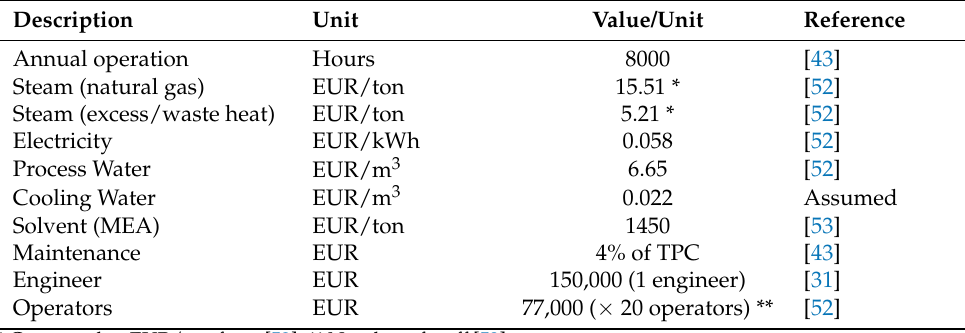
Table 4. Economic assumptions for estimating the operating